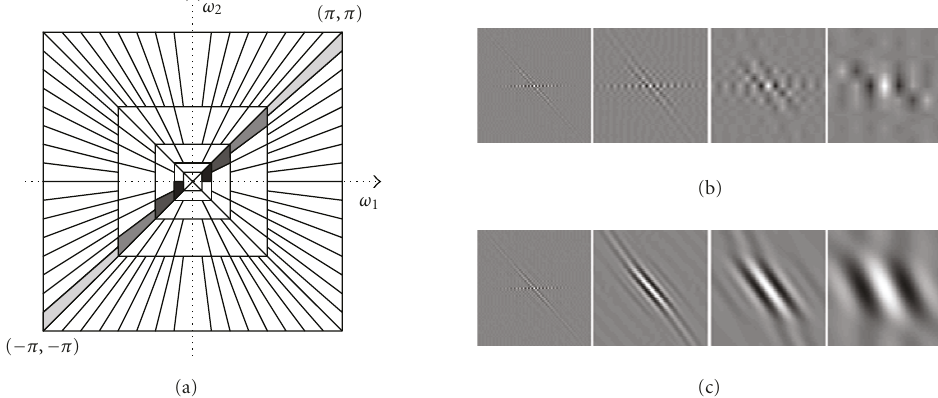
Figure 16: (a) The essential frequency supports of directional filters in the PDFB at di ff erent scales: level 1 with 32 bands, level 2 with 16 bands, level 3 with 8 bands, and level 4 with 4 bands. The corresponding impulse responses in case of (b) aliasing Laplacian pyramid filters and (c) nonaliasing Laplacian pyramid filters.